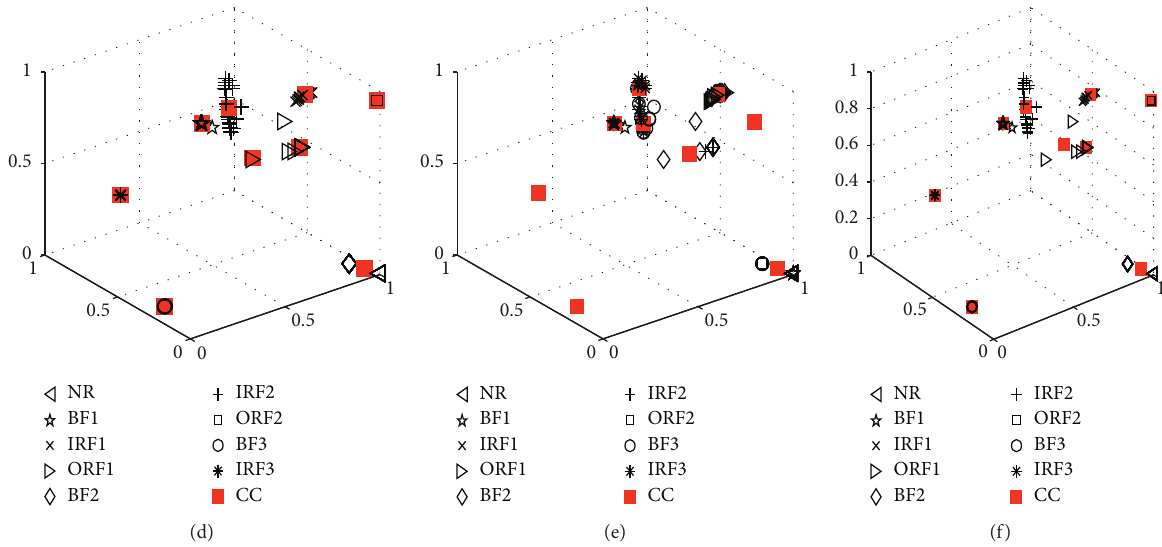
Figure 11: The 3-dimensional clustering results for training dataset A by using an SAE/SDAE with FCM/GK/GG. (a) SAE-FCM-A. (b) SAE- GK-A. (c) SAE-GG-A. (d) SDAE-FCM-A. (e) SDAE-GK-A. (f)